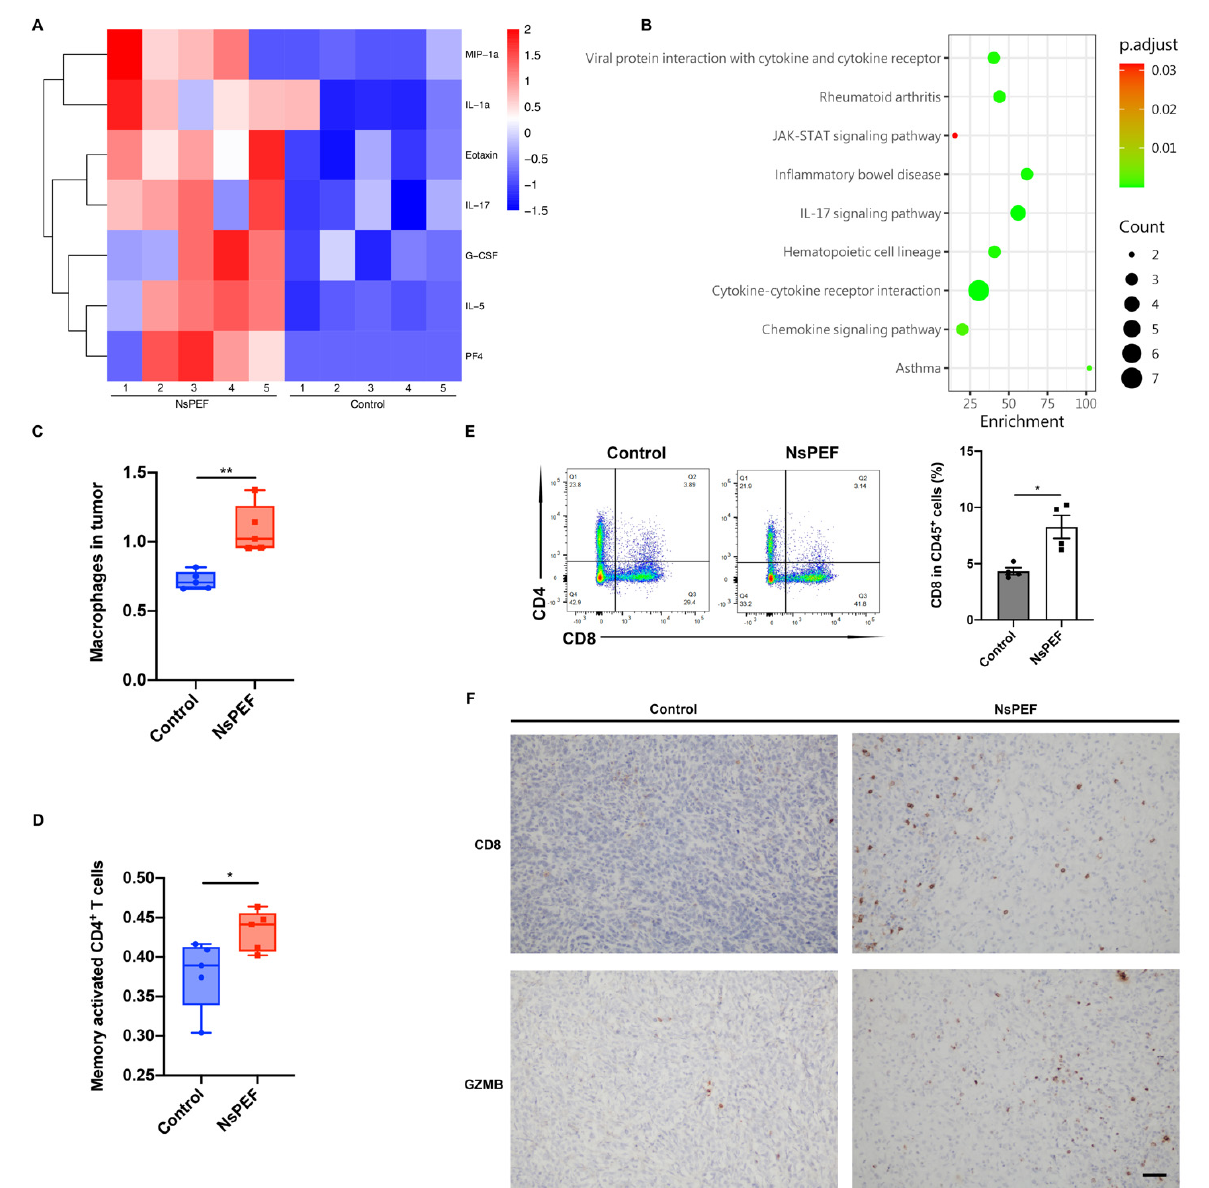
Figure 5. NsPEF activated inflammatory pathways and promoted the activation of immune cells. ( A ) Inflammatory factor micro-array of tumors in the nsPEF group and control group on the third day after treatment; heatmap showing the changes in cytokines ( n = 5, p < 0.05). ( B ) KEGG pathway enrichment analysis of cytokines. ( C ) Macrophages and ( D ) memory activated CD4 + T cells in tumor on day 7 according to the results of CIBERSORTx based on the RNA-seq data. ( E ) Changes in the proportion of CD8 + T cells in CD45 + cells in the control group and the nsPEF group ( n = 4). The flow plot showed the proportion of CD8 + T cells in the CD3 + T cell gate. ( F ) Immuno-histochemistry (IHC) of CD8 and GZMB (Granzyme B) in tumors of the two groups on day 7. Scale bar: 50 μ m. Data are presented as the mean ± SEM; * p < 0.05, ** p < 0.01, according to Student’s t -test.